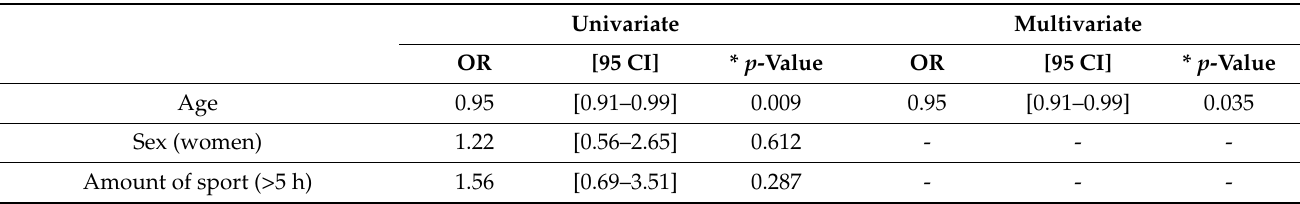
Table A2. Association between alexithymic participants and sport